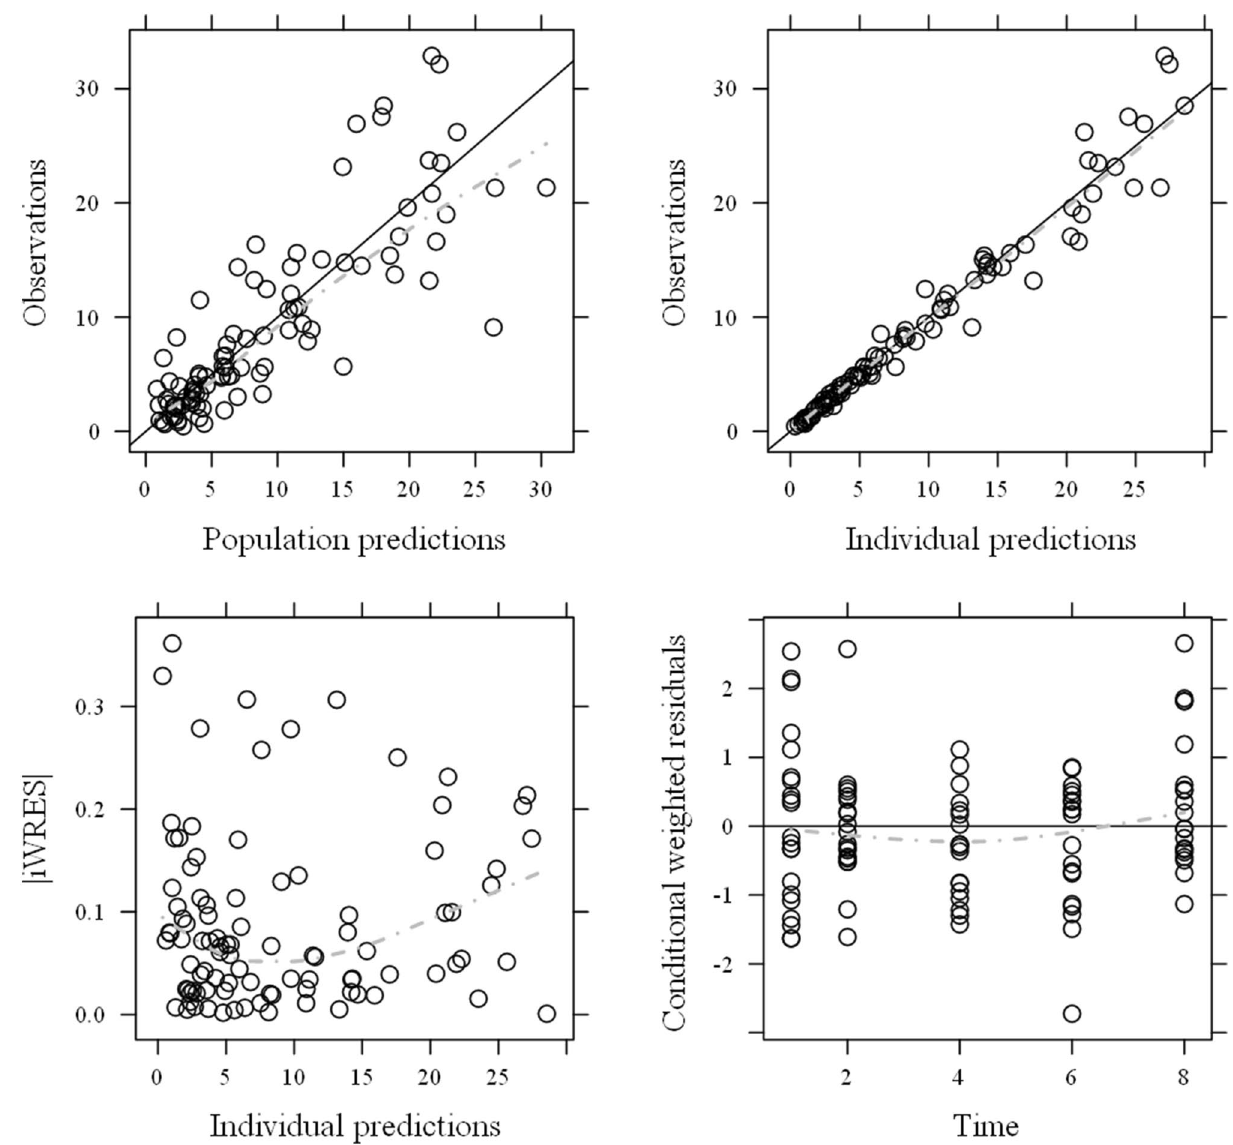
Figure 4. Goodness-of-fit plots for the final model; population prediction (PRED) versus observation (upper left), Bayesian-estimated individual prediction (IPRED) versus observation (upper right), individual weighted residual versus IPRED (lower left), and conditional weighted residual versus time (lower right). The open circles show observations. The solid black line shows the line of identity. The dotted and dashed gray line shows smooth fitting for observations. |iWRES|, absolute individual weighted